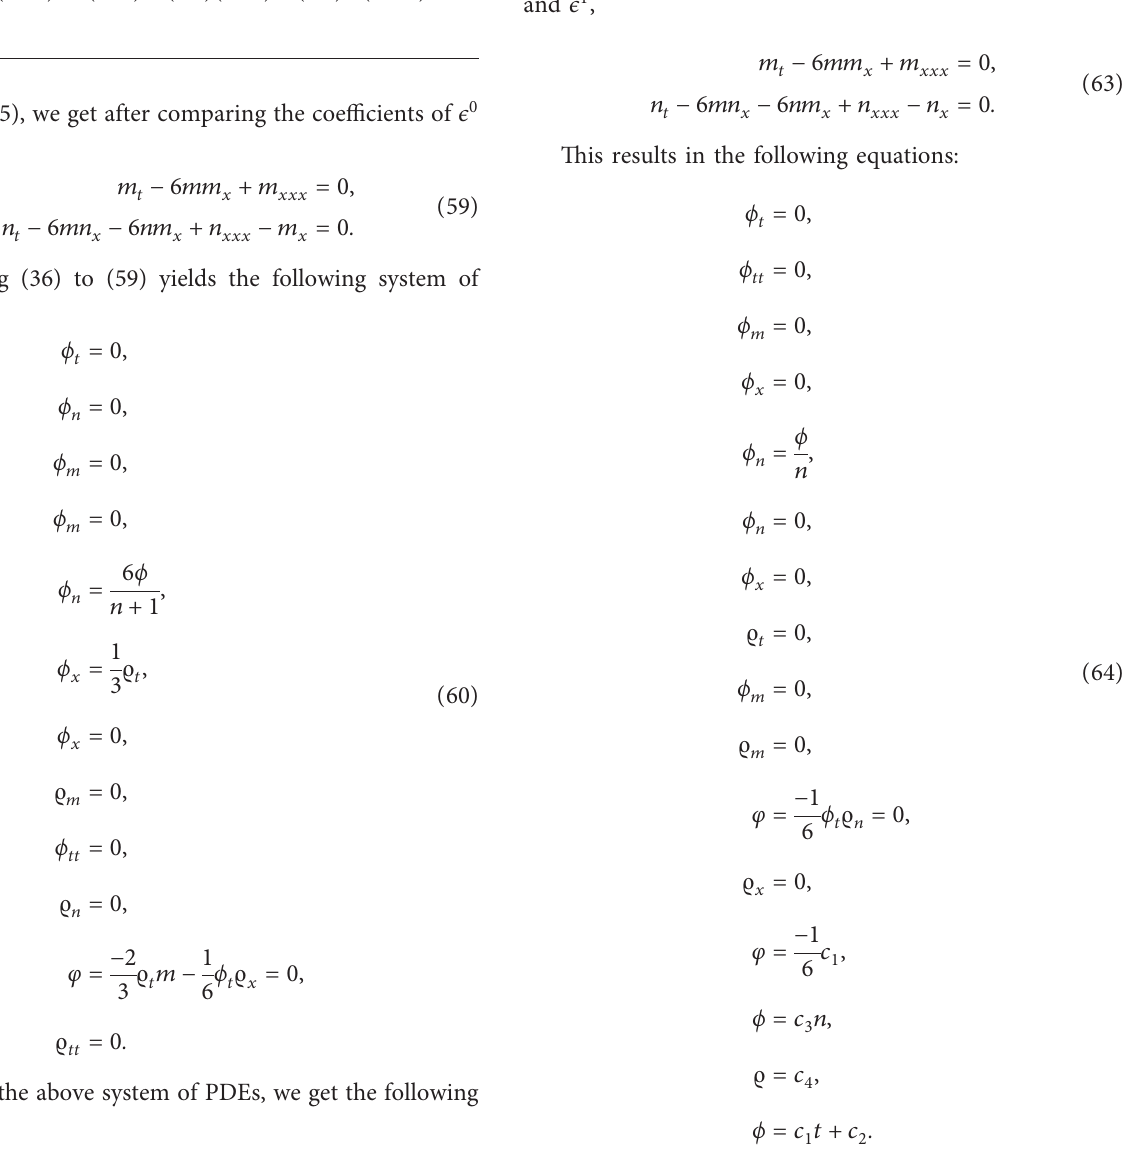
Table 3: Lie symmetry generators. Lie symmetry